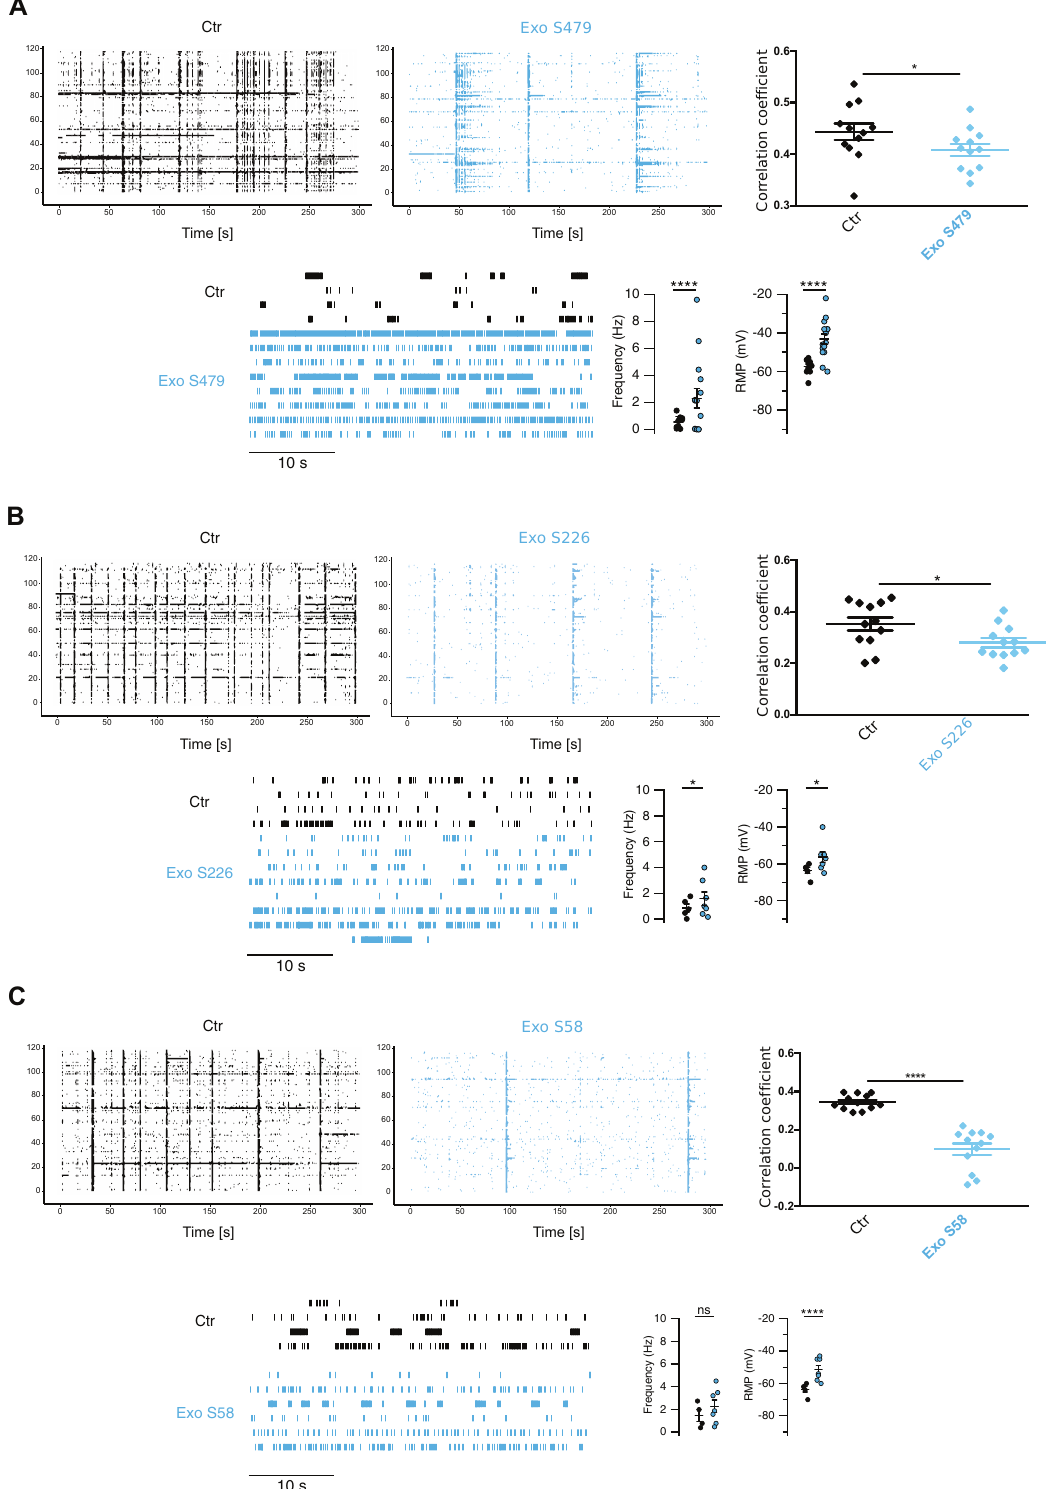
Fig. 6 Exosomes derived from LGG patients increase neuronal excitability and disrupt synchrony. Network-wide and single-cell electrophysiological phenotype of neurons treated with exosomes from LGG patients ( A : S479; B : S226; C : S58). Raster plots from MEA recordings and correlation coef fi cients among spike times are shown in the upper panels, before (Ctr, black) and 24 h after exosome incubation (Exo, blue). The y axes on the raster plots represent channels ’ numbers. The average correlation values across 10 channels were calculated and their distribution compared using Wilcoxon – Mann test; * p < 0.05, *** p < 0.001; n = 12, average of 10 channels. In the lower panels, raster plots of single-cell activity are shown for neurons treated with patients ’ exosomes and the respective controls. The distributions of fi ring rate (Hz) and resting membrane potentials (RMP) are shown; statistics were performed using the Wilcoxon – Mann – Whitney U test; * p < 0.01, **** p < 0.0001; n = 9/15 for S479, 5/7 for S226, 4/7 for S58 (neurons analyzed in Ctr/Exo samples,